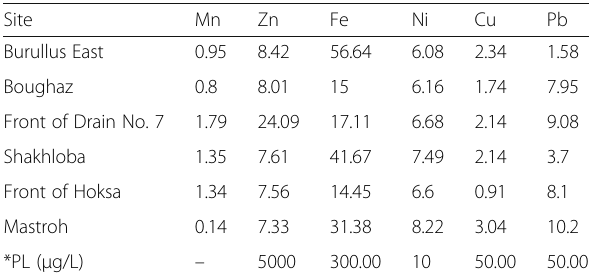
Table 4 Annual mean of heavy metal concentration ( μ g/L) in Burullus Lake water during 2014